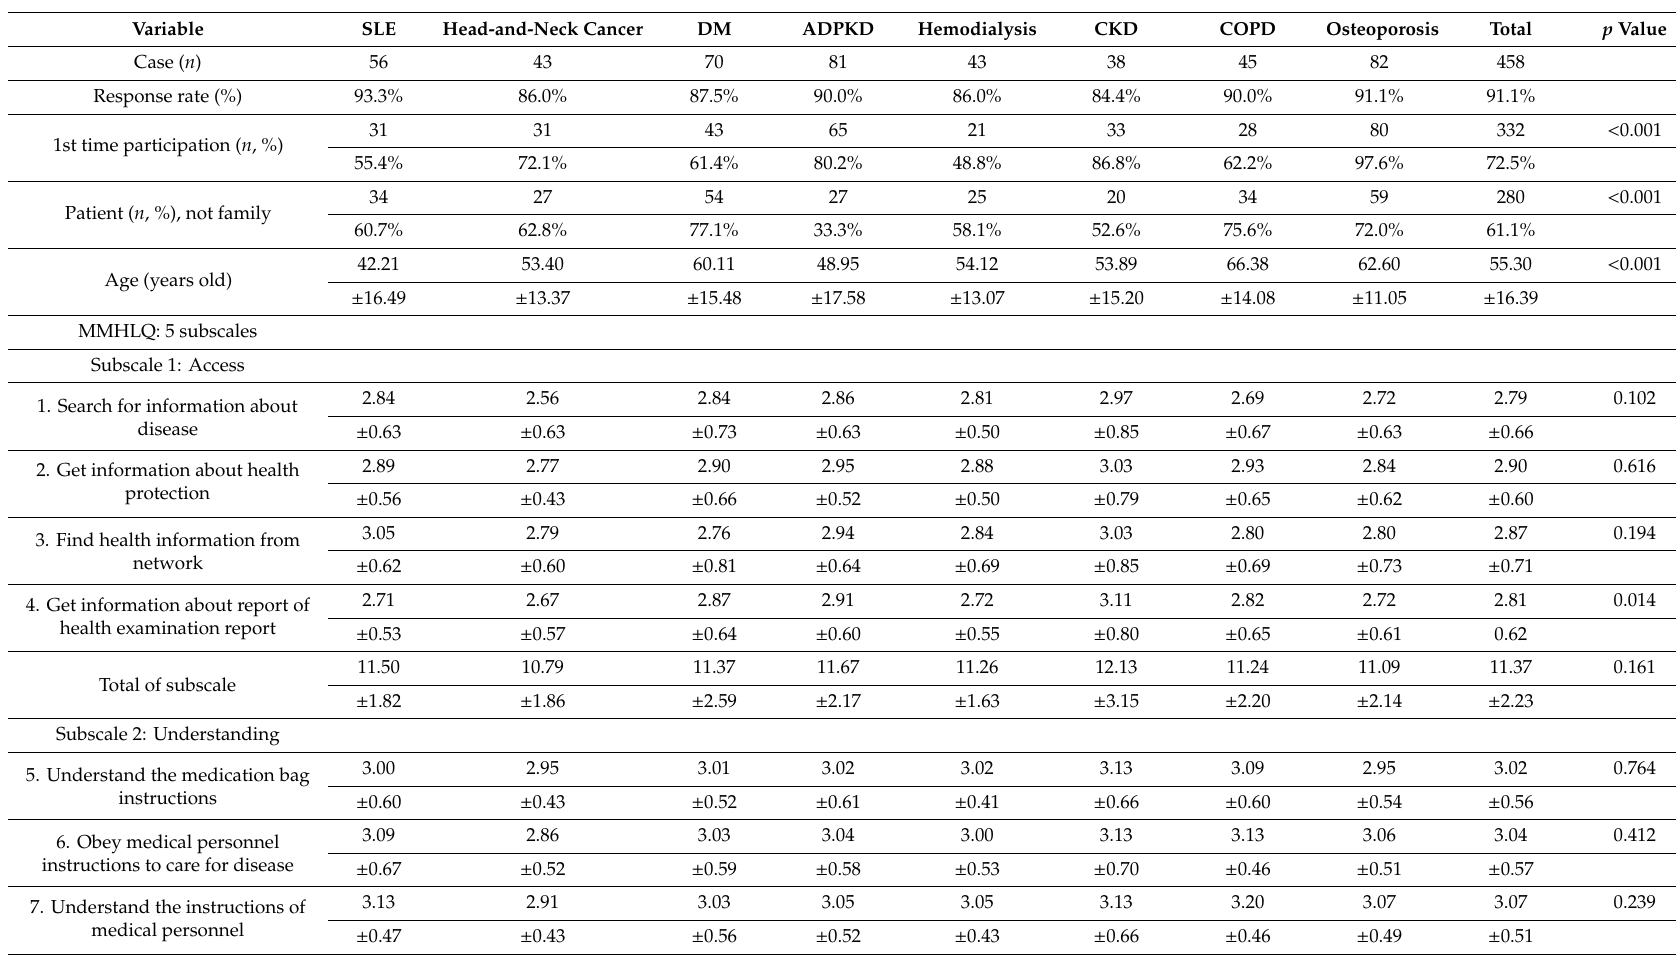
Table 1. Background characteristics of participants and score of the Mandarin Multidimensional Health Literacy Questionnaire (MMHLQ) divided by patient support groups (PSGs) ( n = 458) (mean ±